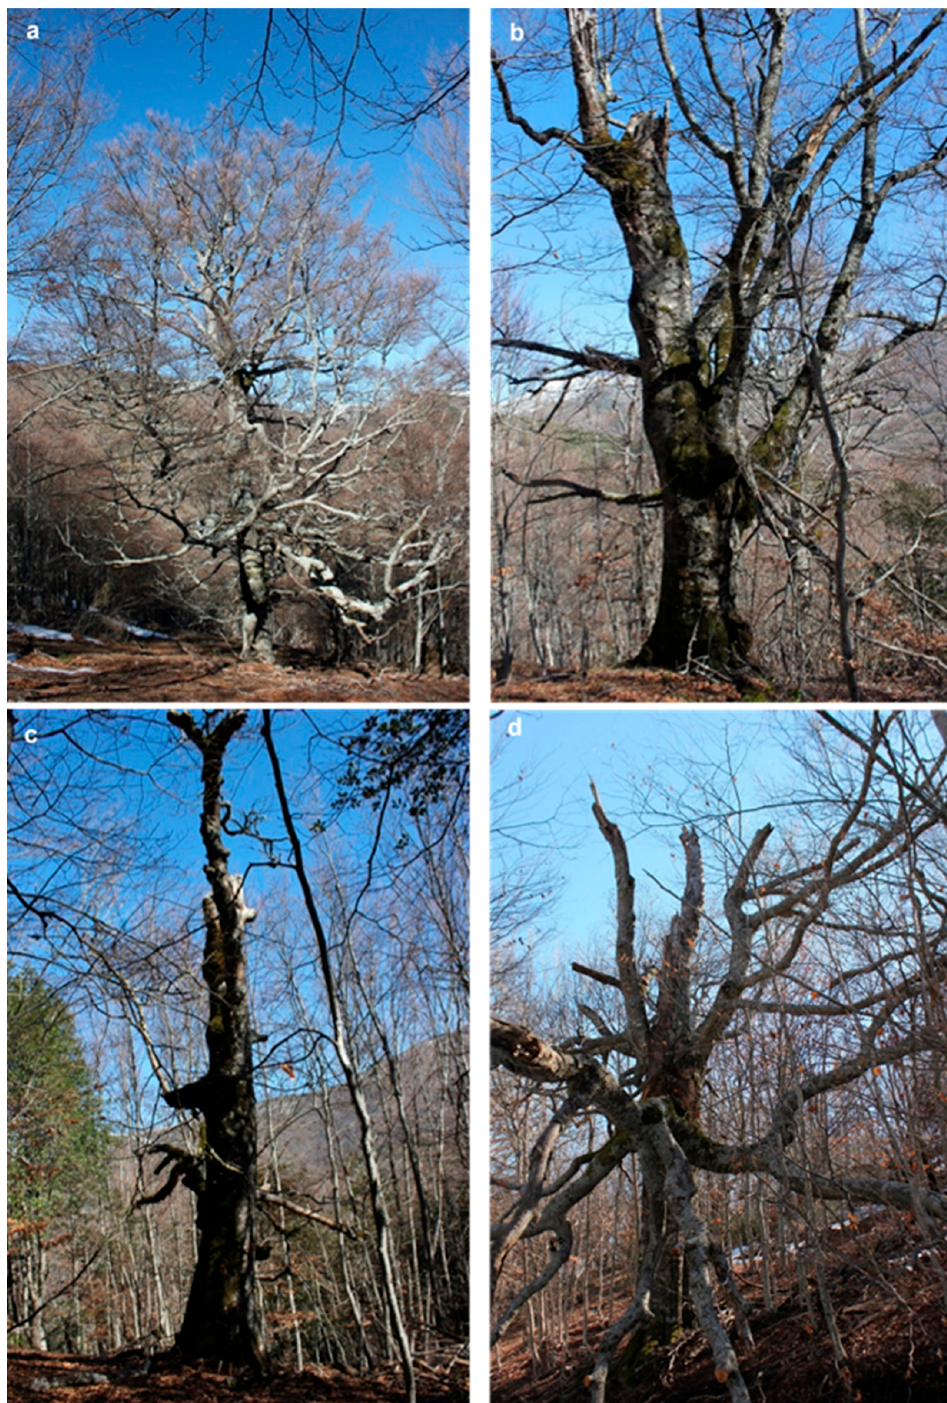
Figure 1. Examples of centennial beech trees around which soil respiration measurements were conducted. Tree decline classes were established in relation to the crown dieback: Vigorous ( a ; no apparent crown dieback), a ff ected ( b ; less than 40% crown dieback), severely a ff ected ( c ; more than 50% crown dieback), and dead ( d )